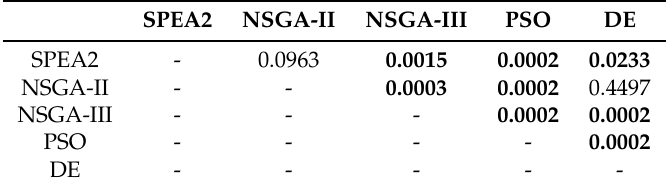
Table 2. Pairwise Mann–Whitney–Wilcoxon U test. Significant values are those p -values (<0.05) shown in bold.